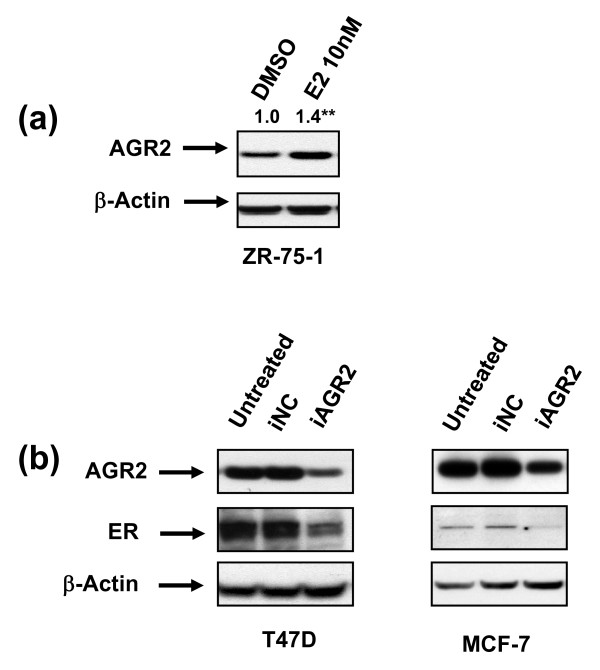
Evidence of ER-AGR2 crosstalk. (a) ZR-75-1 cells were treated with vehicle control (DMSO) or E2 (10 nM) for 24 hours analyzed with Western blot. Numbers above bands represent relative AGR2 induction with E2 treatment after quantitation and normalized to β-actin (Image J). (b) Lysates 72 hours after AGR2 knockdown were analyzed with Western blot for ER. **P < 0.01. Note: Some blots may be from different gels run with the same set of samples.